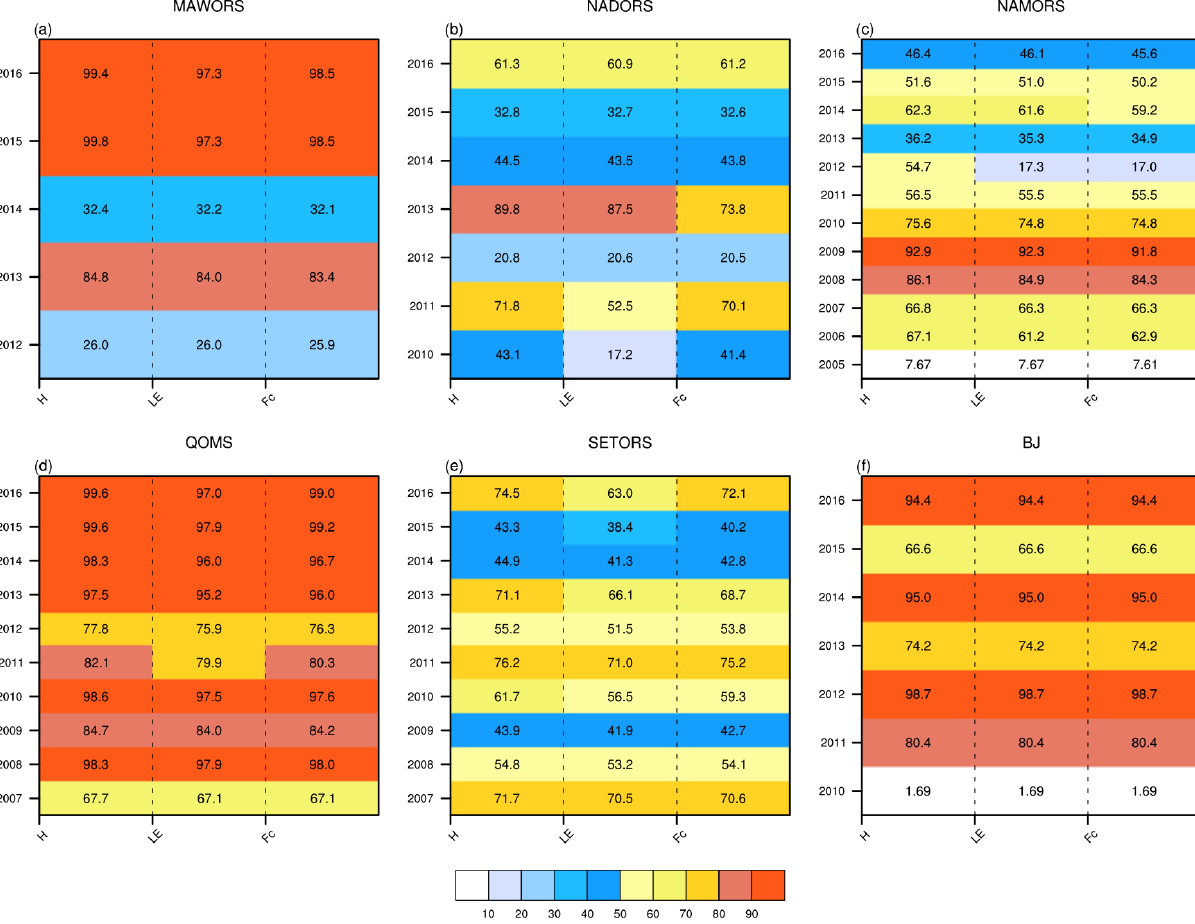
Figure A4. Same as Fig. A1, but for the turbulent flux observations. H represents sensible heat flux, LE represents latent heat flux, and the CO 2 flux is expressed with